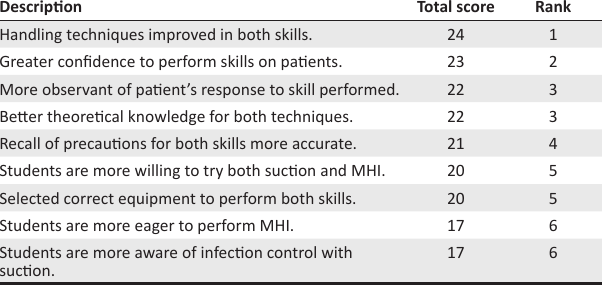
TABLE 3: Final ranking of clinical educators’ opinions on skills implementation during intensive care unit clinical practice. Description Total score Rank